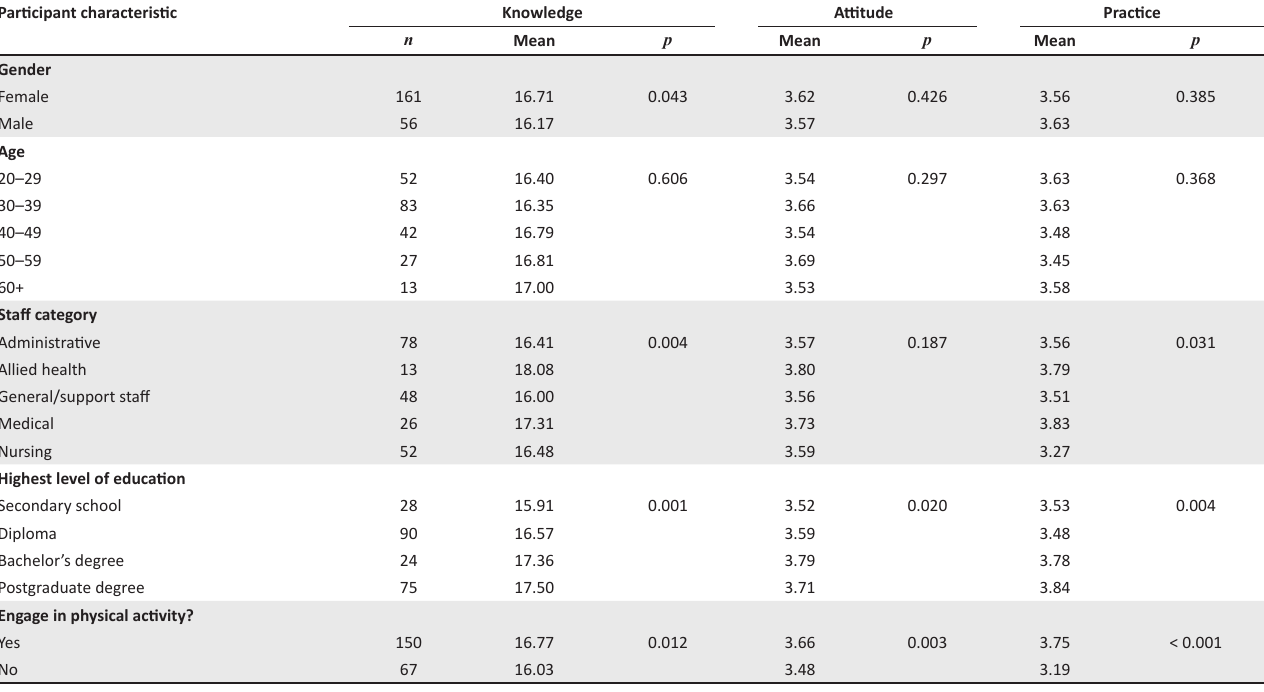
TABLE 6: Differences in knowledge, attitudes and practices and respondent characteristics. † Participant